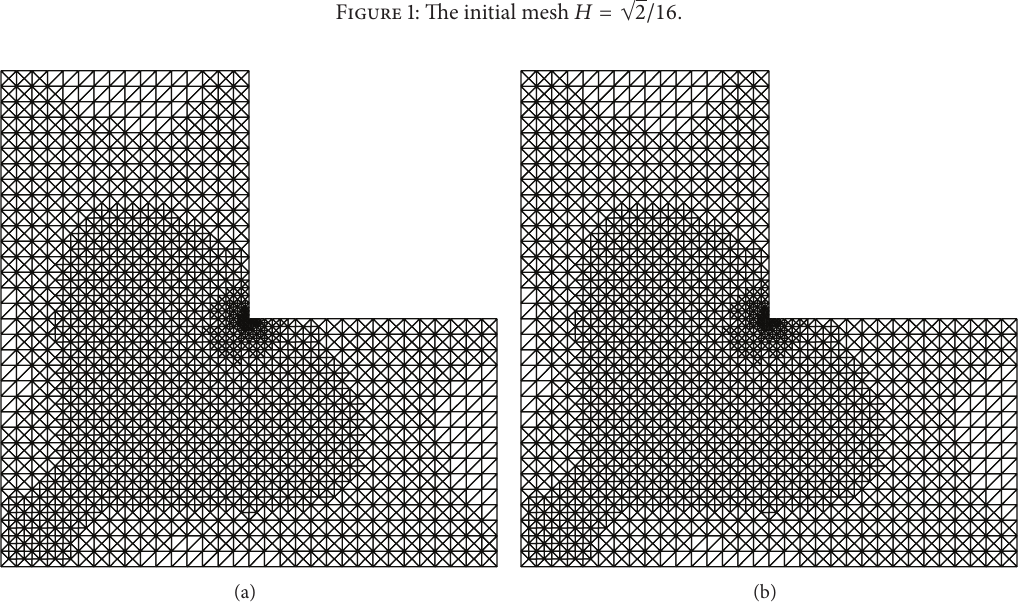
Figure 1: The initial mesh 𝐻 = √2/16 .